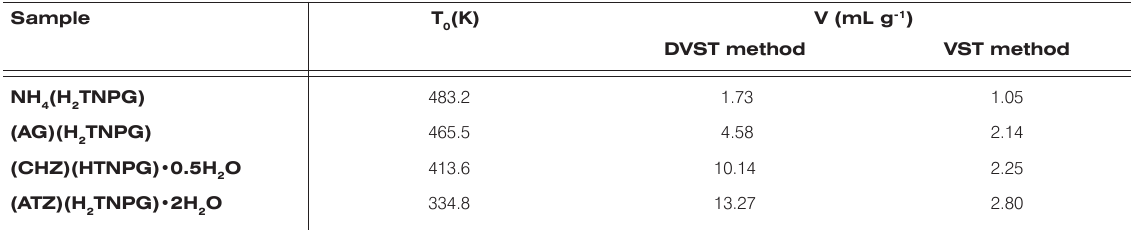
(H TNPG), (AG)(H 4 2